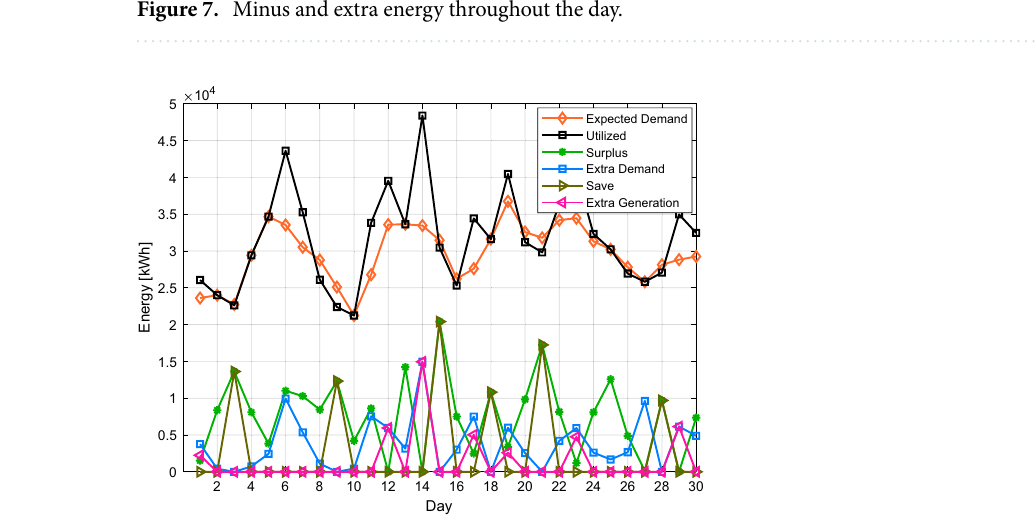
Figure 8. Demand and surplus generated power for a